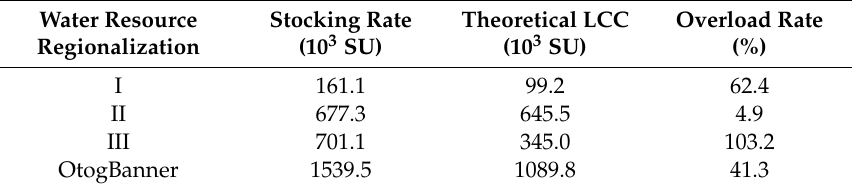
Table 6. Analysis of stocking capacity balance based on dynamic FLB.